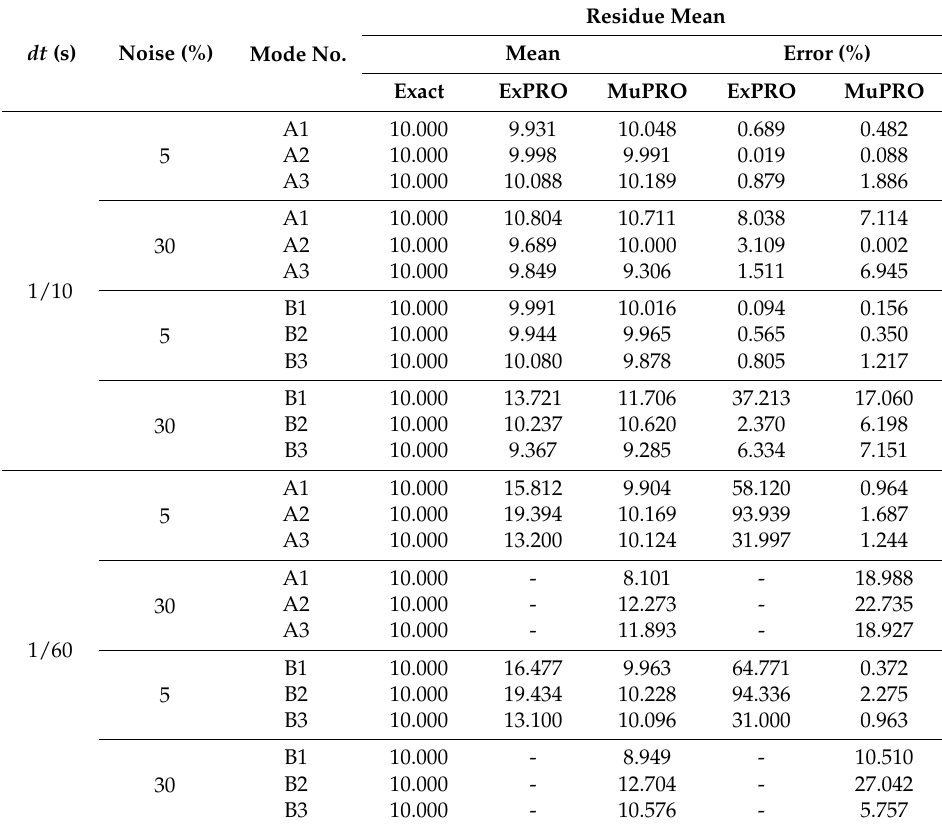
Table 4. Estimated residue